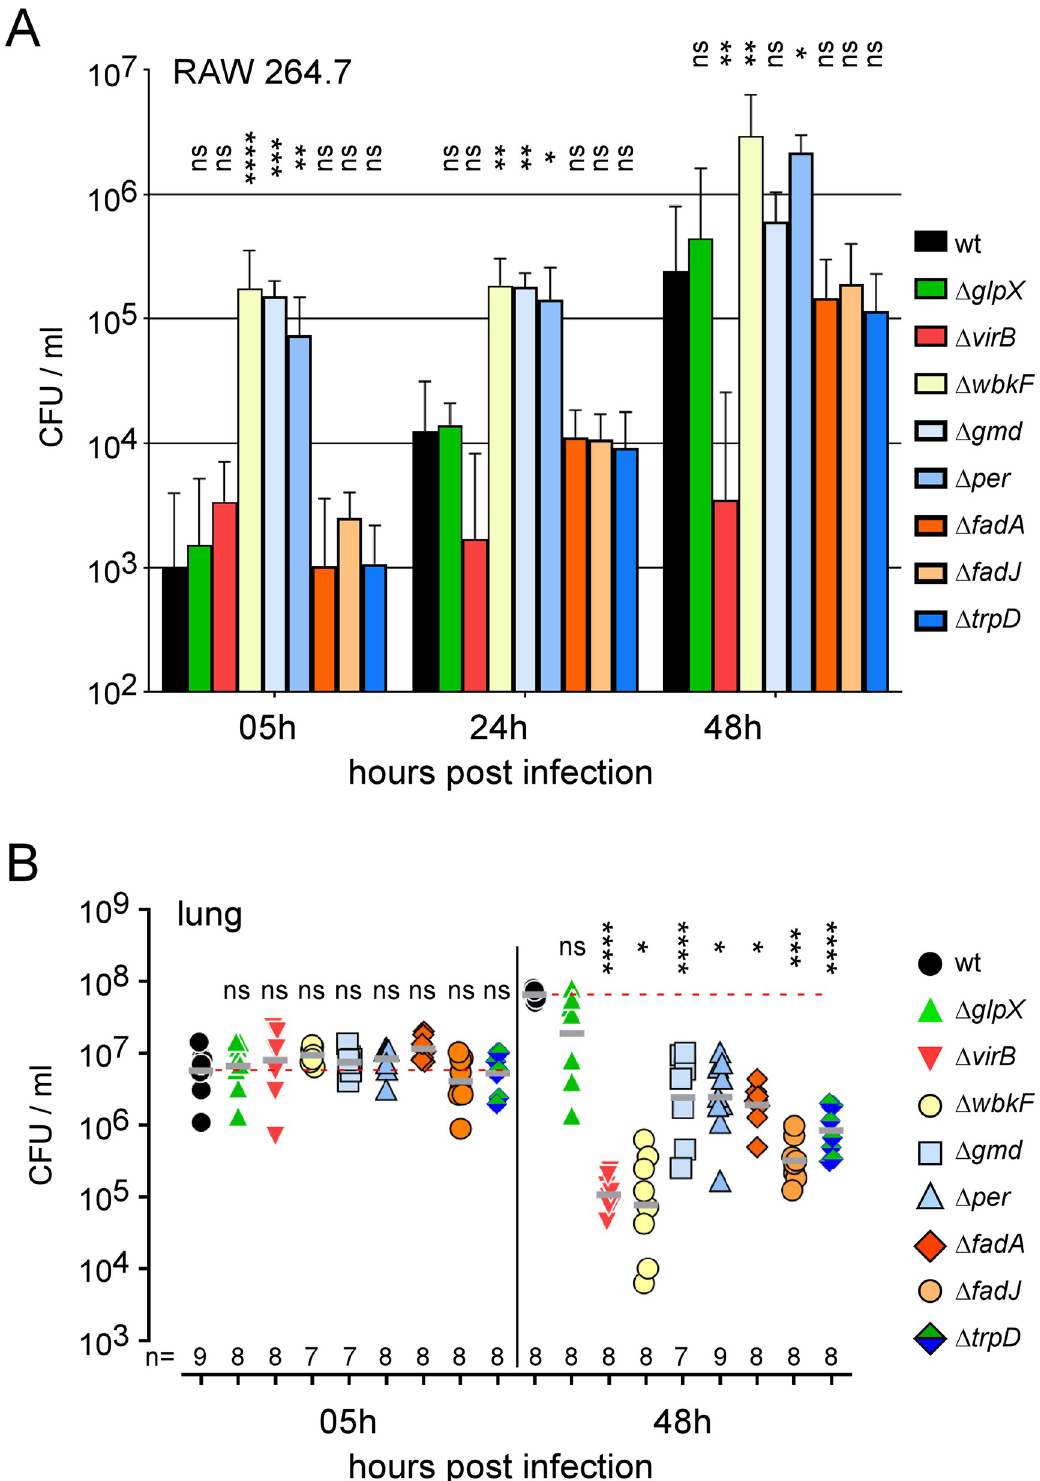
Fig 8. Functional confirmation of the prediction derived from the Tn-seq analysis of RAW 264.7 and lung conditions. Data shown are bacterial count (CFU) at the indicated time post-infection in RAW 264.7 ( A ) and lung from wild-type mice infected intranasally ( B ) with wild-type (wt), Δ glpX , Δ virB , Δ wbkF , Δ gmd , Δ per , Δ fadA , Δ fadJ and Δ trpD strains of B . melitensis at a dose of 5x10 6 CFU and a MOI of 1:50, respectively. Significant differences between wt and the indicated groups are marked with